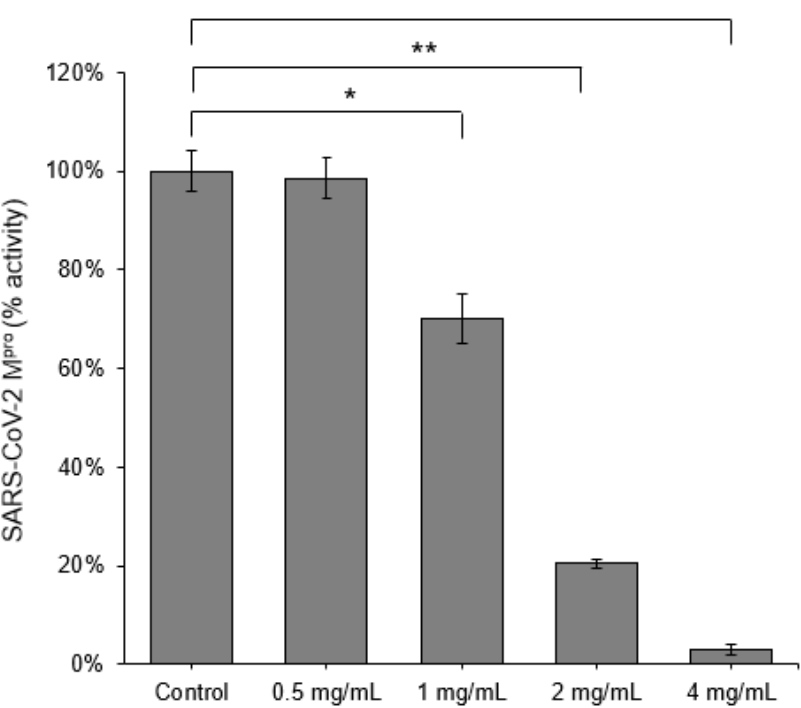
Figure 1. Scutellaria barbata inhibited the protease activity of SARS-CoV-2 M pro in vitro FRET-based enzyme activity assay of SARS-CoV-2 M pro in the absence or presence of Scutellaria barbata treat- ment with two folds series dilution from 0.5 mg/mL to 4 mg/mL. All data were represented as mean ± standard deviation (SD). Statistical significance was calculated using student t -test. ANOVA was performed when multiple comparisons were evaluated. *, p < 0.05. **, p < 0.01. ***, p <